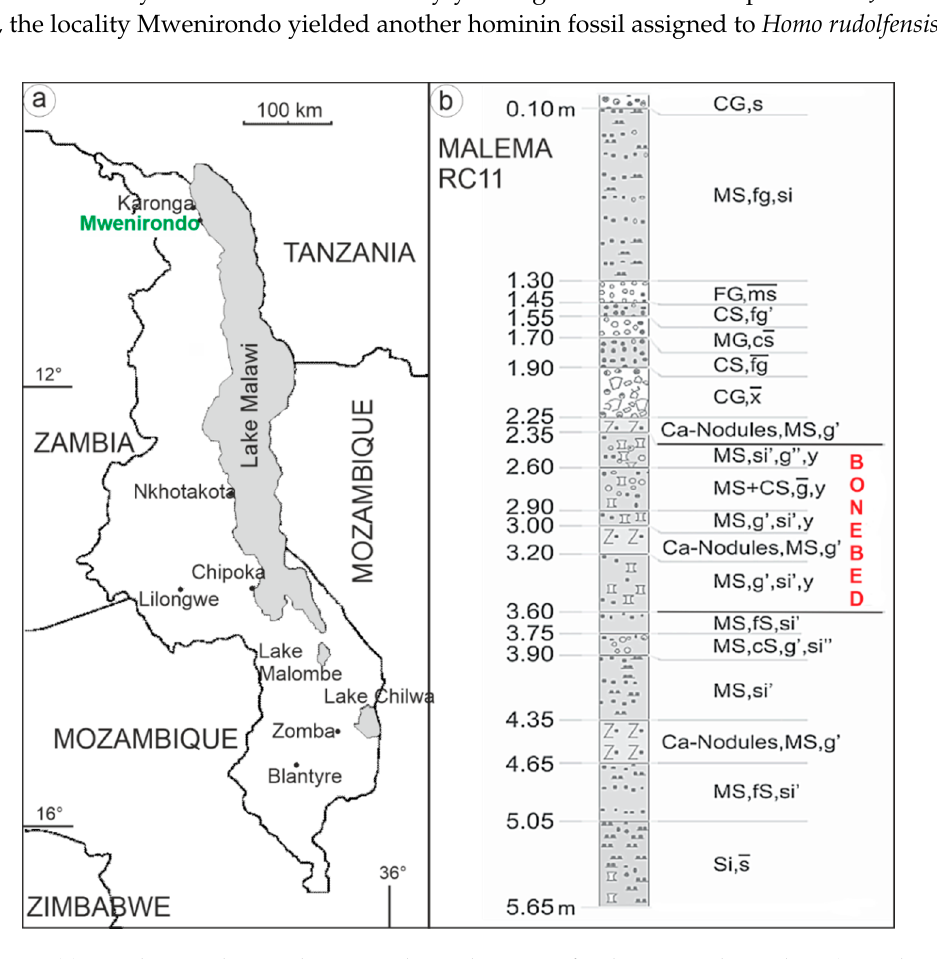
Figure 1. ( a ) Map showing the main location in the northern part of Malawi. Note that Malema (not indicated here) is very close from Mwenirondo (500 m). ( b ) Lithological section, RC11 locality of unit 3A, showing the bone bed layers. Si = silt, si = silty; fs = fine sand; ms = middle sand; cs = coarse sand; s = sandy; fg = fine gravel; mg = middle gravel; cg = coarse gravel; g = gravelly; x = stone; y = boulder; quantity of sediment fraction ‘ = slight, ‘‘ = very slight, — = strong. Redrawn from [8].